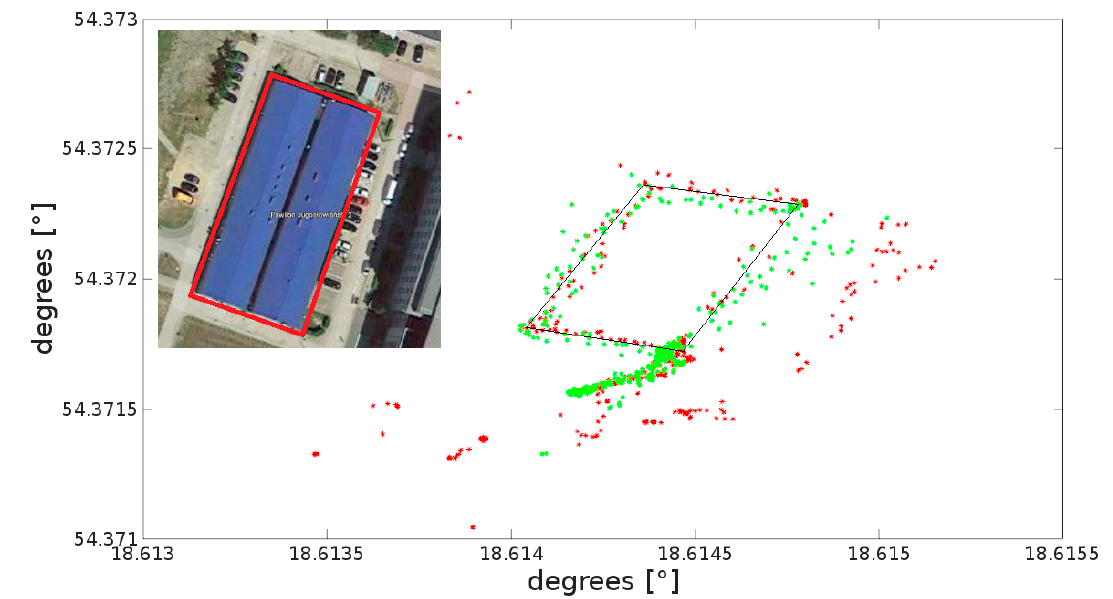
Figure 11. Sample results of determining position coordinates for dynamic measurements in urbanized areas. In the insert the true trajectory is depicted on the photograph with a red line.